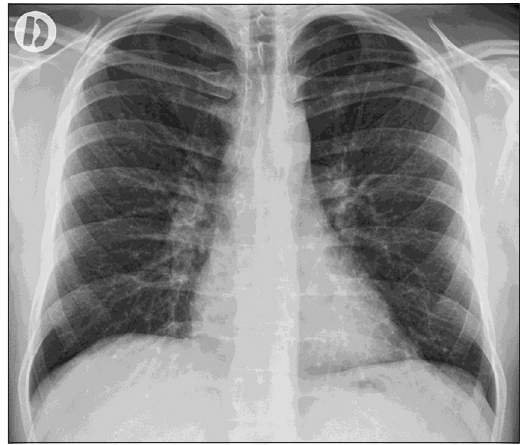
FIGURE 4. Chest X-ray – July 9,